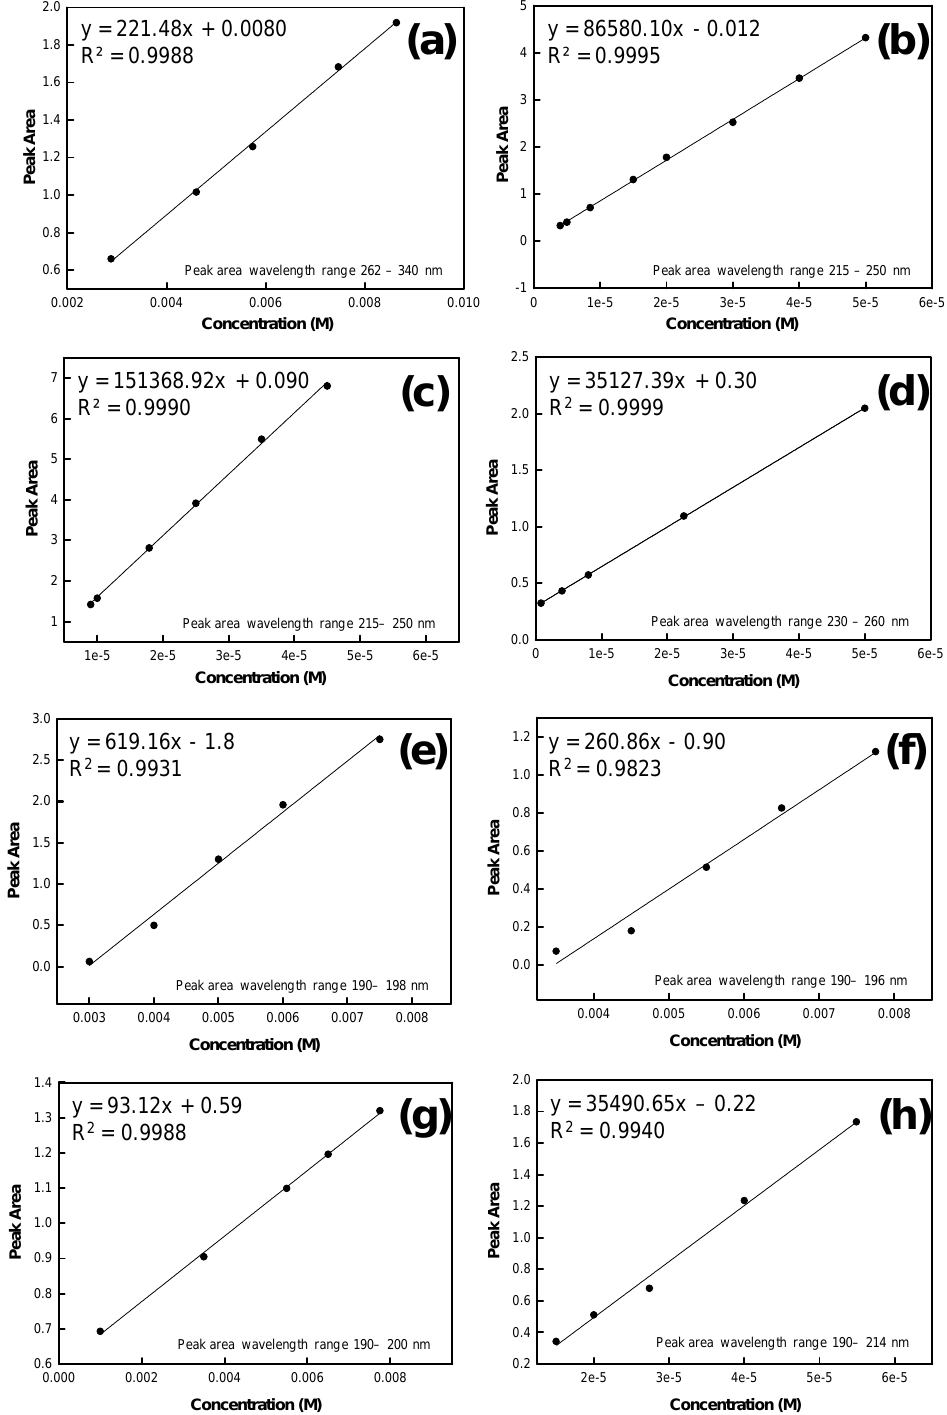
Figure 2. Calibration curve and R 2 value from one UV-Vis data set at various analyte concentrations for ( a ) AN; ( b ) TNT; ( c ) HMX; ( d ) RDX; ( e ) urea; ( f ) potassium chloride; ( g ) sugar; and ( h ) PETN. Wavelength ranges used to determine the peak areas for each analyte are also